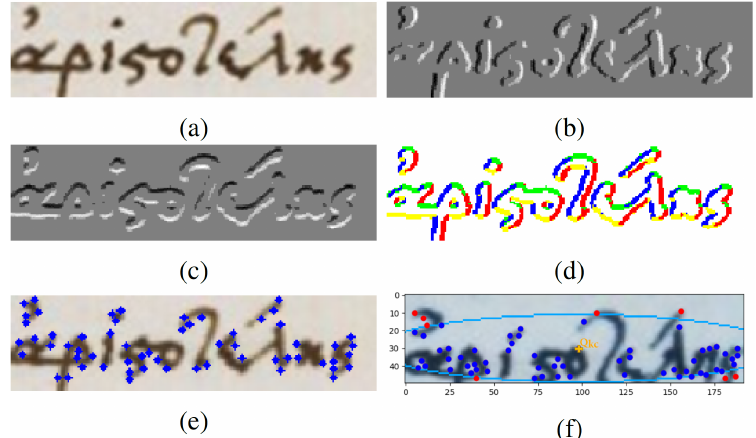
Figure 3. The proposed word spotting indexing and matching pipeline for the Greek handwritten word of ’Aristotle’. ( a ) Query image; ( b ) filtered gradient image I x ; ( c ) filtered gradient image I y ; ( d ) quantization of the gradient orientation; ( e ) keypoints; ( f ) query keypoint (yellow) and the ellipse area enclosed keypoints (blue) that should be matched during the matching